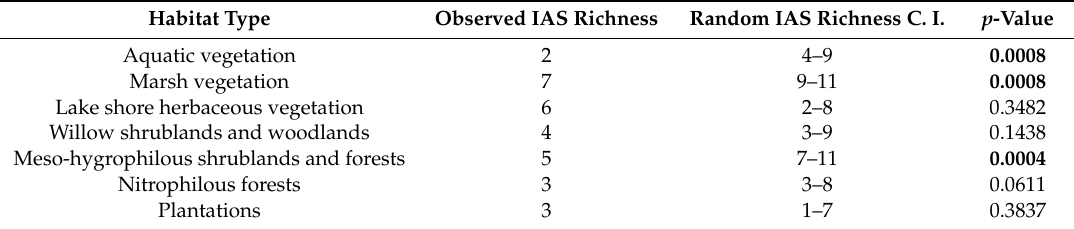
Table 4. For each habitat type the observed IAS richness values are shown with the 95% confidence intervals of the random IAS richness and the p -values (two-tailed test) obtained by reshu ffl ing the matrix assembled with the random frequencies of each IAS per habitat 9999 times (keeping the IAS probability resulting from the first null model simulations fixed). In bold, the p -values are significantly lower than